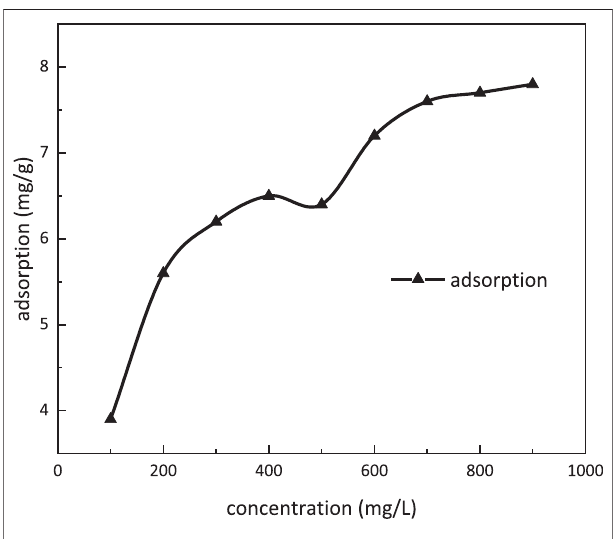
FIGURE 11 | Absorbance dependence on benzene